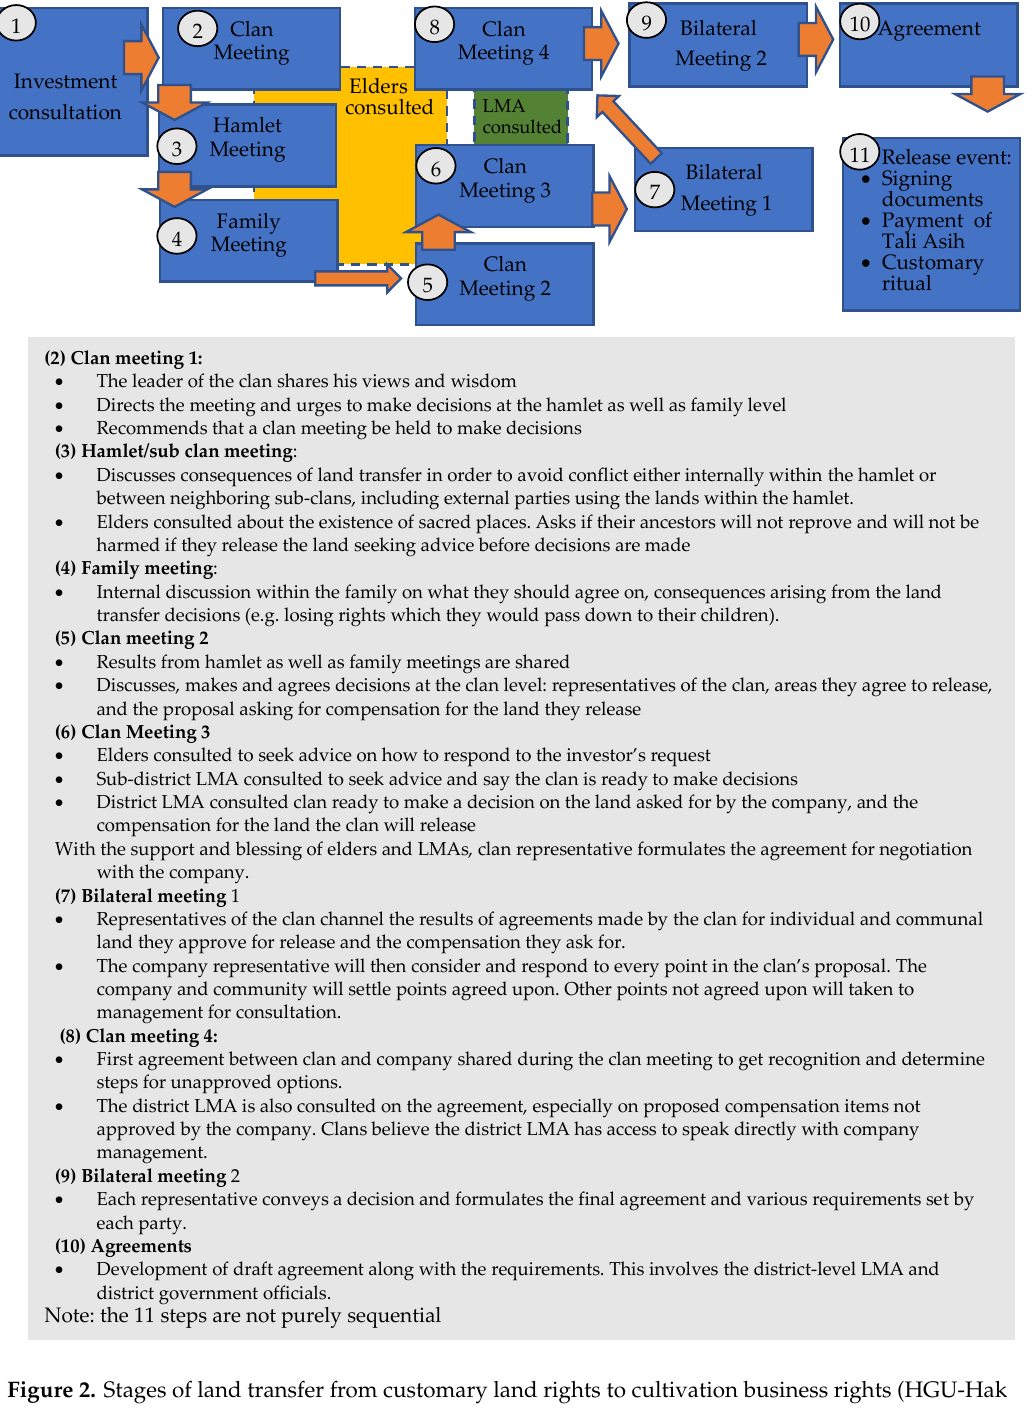
Figure 2. Stages of land transfer from customary land rights to cultivation business rights (HGU-Hak Guna Usaha) from customary communities to investors.